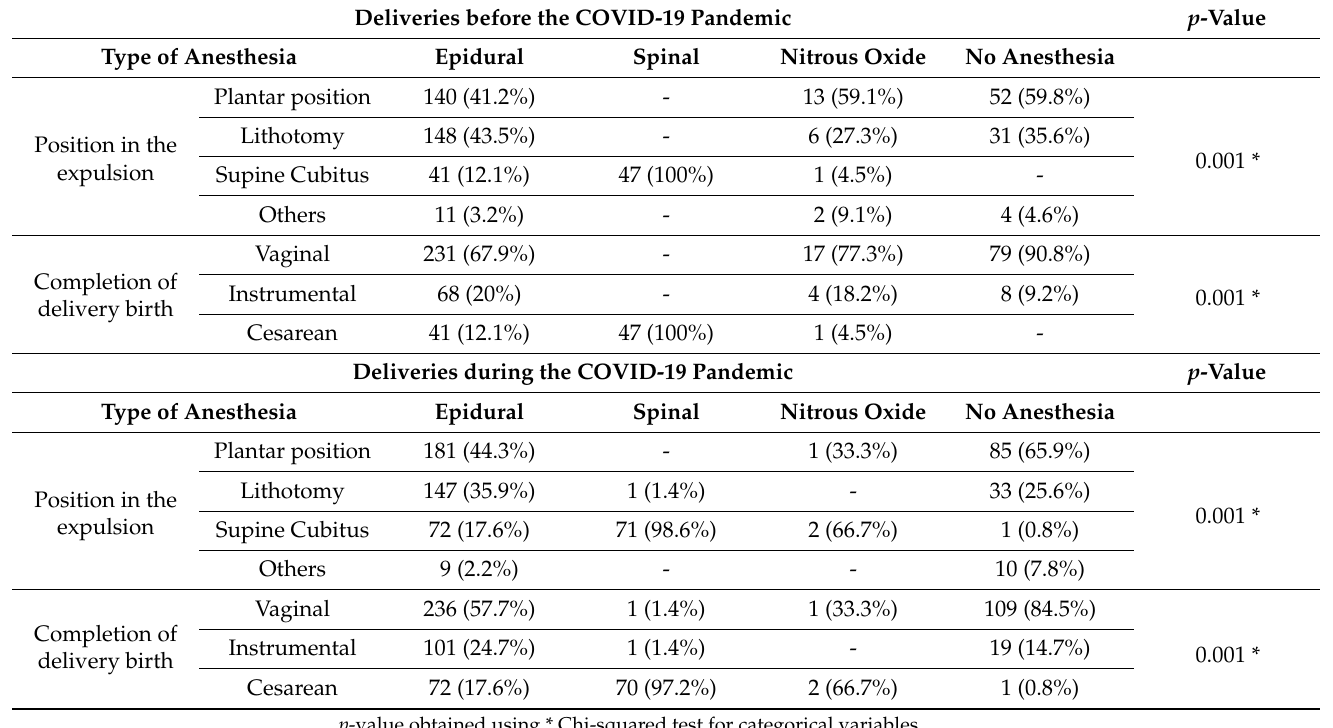
Table 3. Type of anaesthesia for position in the expulsion and obstetric procedures “before the COVID-19 pandemic” and “during the COVID-19 pandemic”.